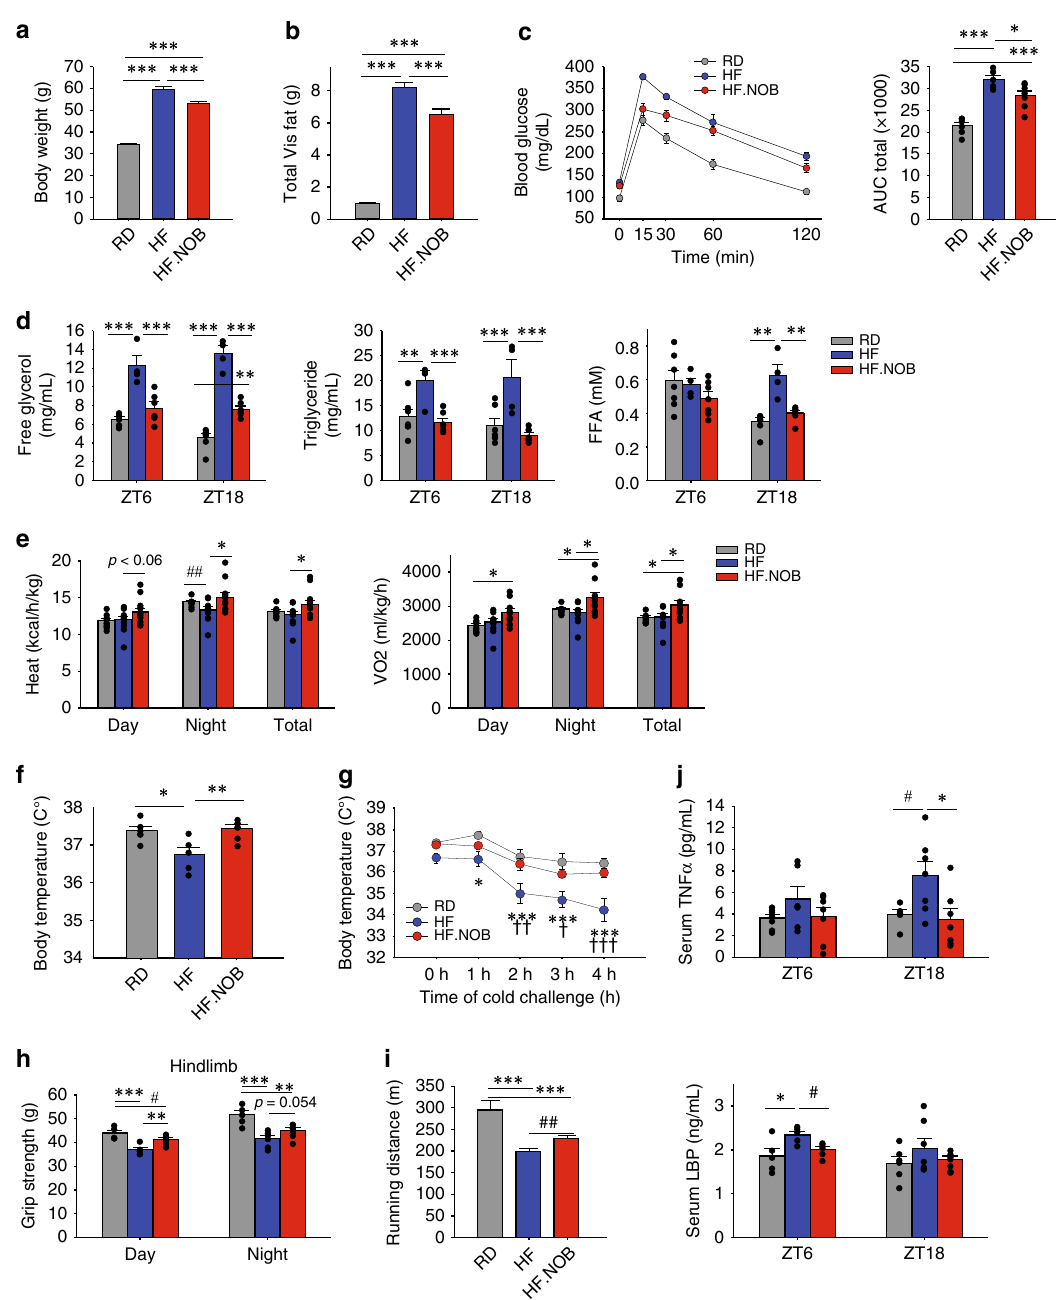
Fig. 2 NOB improved adiposity, glucose homeostasis, and fi tness in high-caloric conditions. Aged mice were fed with regular diet (RD), high-fat (HF) diet, or HF diet with NOB (HF.NOB). a End point (after 20 – 22 weeks of treatment) body weight and b total Visceral (Vis) fat mass (including perigonadal fat, perirenal fat, and mesenteric fat) were measured ( n = 20, 16, and 17 for RD, HF, and HF.NOB, respectively). c Glucose tolerance test and area under curve (AUC) ( n = 6, 5, and 7 for RD, HF, and HF.NOB, respectively). d Serum lipid homeostasis parameters were measured at indicated time points ( n = 7, 4, and 6 for RD, HF, and HF.NOB, respectively). e In vivo heat production and oxygen consumption measured in metabolic chamber. Average values of day, night, and total are shown ( n = 9, 10, and 10 for RD, HF, and HF.NOB, respectively). f Core body temperature ( n = 6, 4, and 7 for RD, HF, and HF.NOB, respectively). g Cold tolerance test ( n = 6, 5, and 7 for RD, HF, and HF.NOB, respectively; *HF vs. RD, † HF vs. HF.NOB, two-way ANOVA). h Hindlimb grip strength test ( n = 5, 6, and 8 for RD, HF, and HF.NOB, respectively). i Running distances were measured with treadmill under HF conditions ( n = 12, 11, and 12 for RD, HF, and HF.NOB, respectively). j In fl ammation markers including TNF α (upper panel) and LBP (lower panel) (ZT6, n = 7, 6, and 7 for RD, HF, and HF.NOB, respectively; ZT18, n = 6, 8, and 7 for RD, HF, and HF.NOB, respectively). Color schemes are the same in all panels: gray, RD; blue, HF; red, HF. NOB. * p < 0.05, ** p < 0.01, *** p < 0.001, one-way ANOVA; # p < 0.05, ## p < 0.01, ### p < 0.001, t -test. Data are presented as mean ± SEM in bar